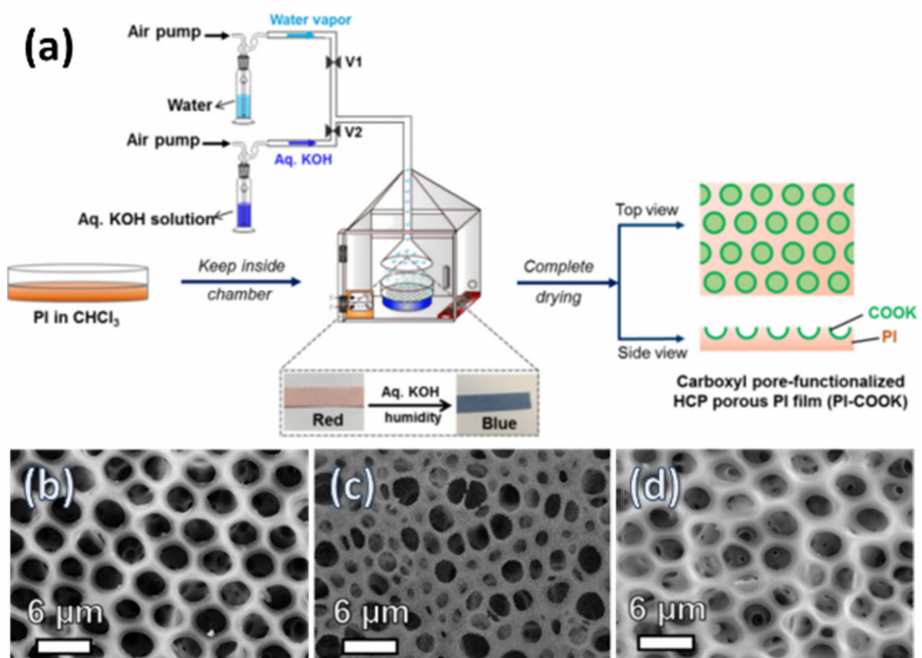
Figure 17. ( a ) Schematic representation showing the fabrication of the pore-selective carboxyl func- tionalized PI HCP films (PI-COOK) via BF method under aq. KOH humidity with a time interval after using initial water humidity. SEM images of PI films fabricated under ( b ) water humidity, ( c ) aq. KOH humidity, and ( d ) under aq. KOH humidity for 20 min after initial water humidity. Reprinted with permission from ref. [111]. Copyright 2018 Polymer.